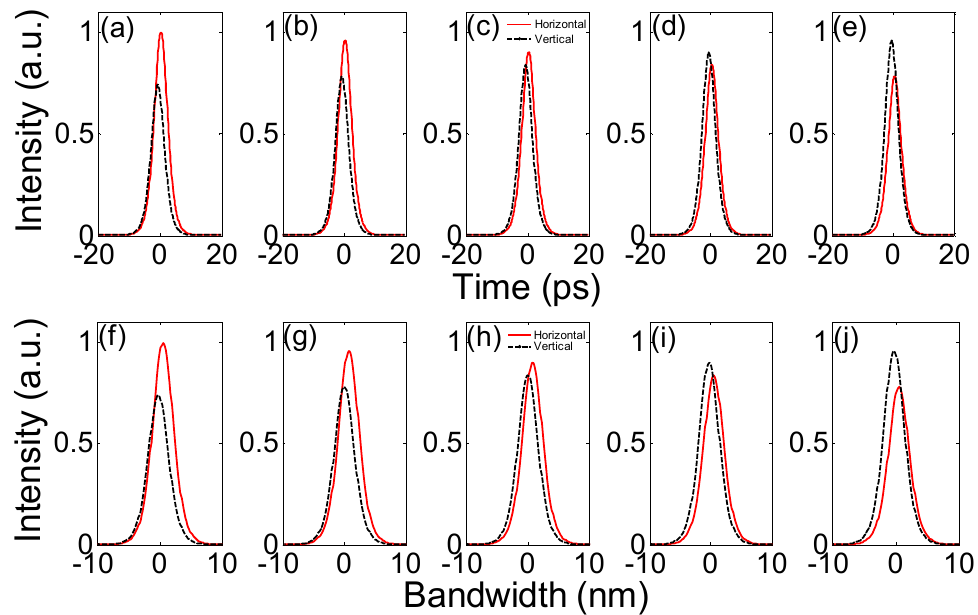
Figure 6. Theoretical results after polarization splitting when the phase difference is changed and λ 1 = λ 2 = 1064 nm.